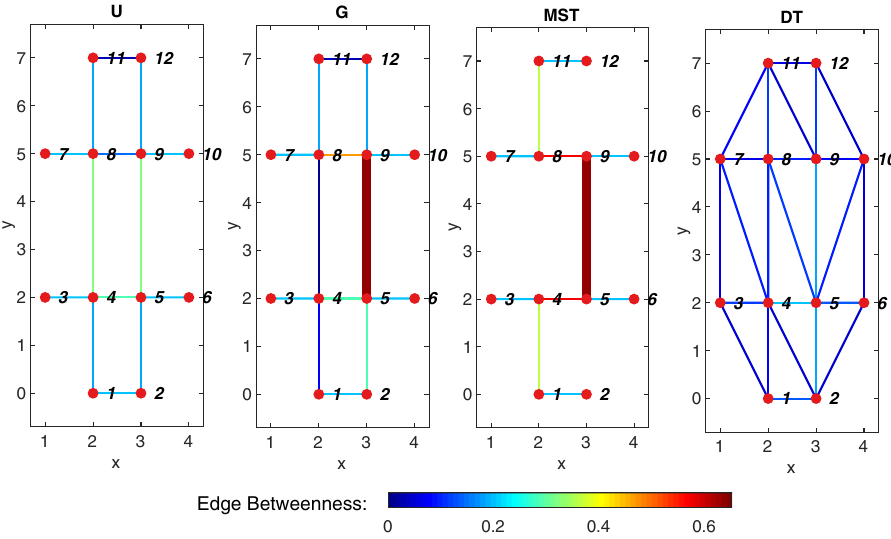
Figure 2. Sample graph. U: sample undirected graph connecting 12 nodes, all the edges in the graph have a uniform edge width. G: sample graph with the same topology as graph U, but an increased edge width between nodes 5 and 9. MST: Minimum spanning tree for U and G, some edges disappear from the graphs to form a simply connected network with minimum length. DT: Delaunay triangulation of graphs U and G, the triangulation is a maximum connected graph between the nodes, irrespective of the edge or node weights of the graph. The edge color is proportional to the edge betweenness in the